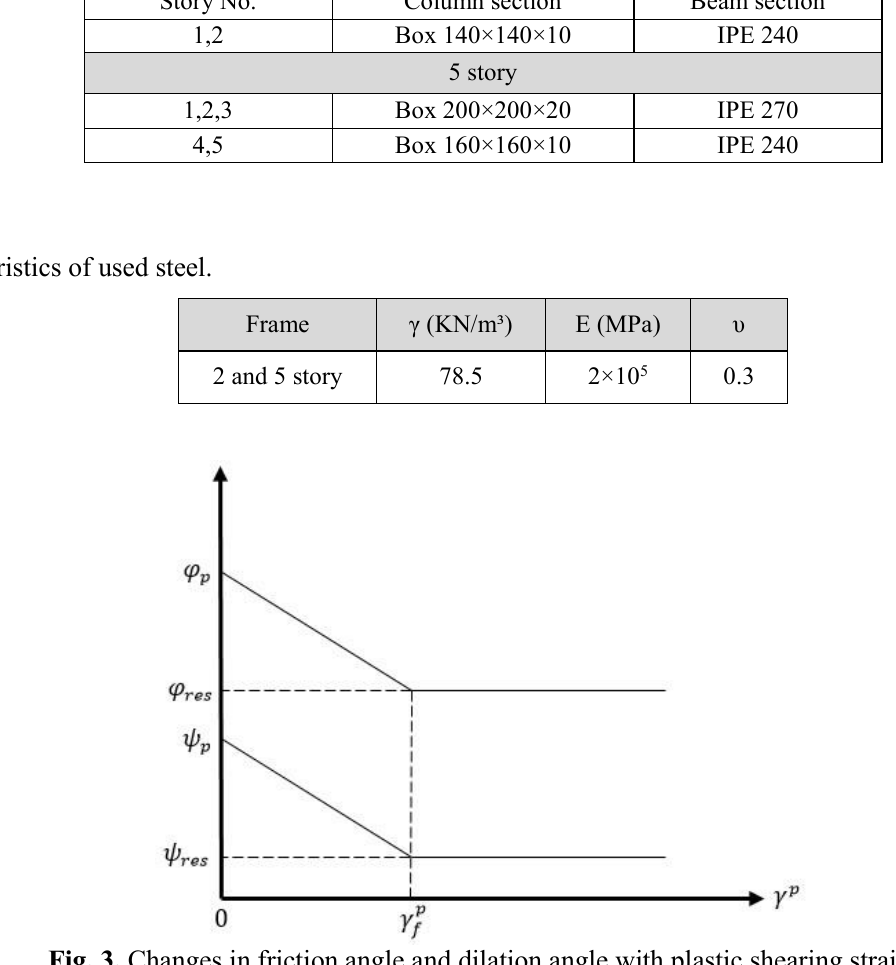
Fig. 3. Changes in friction angle and dilation angle with plastic shearing